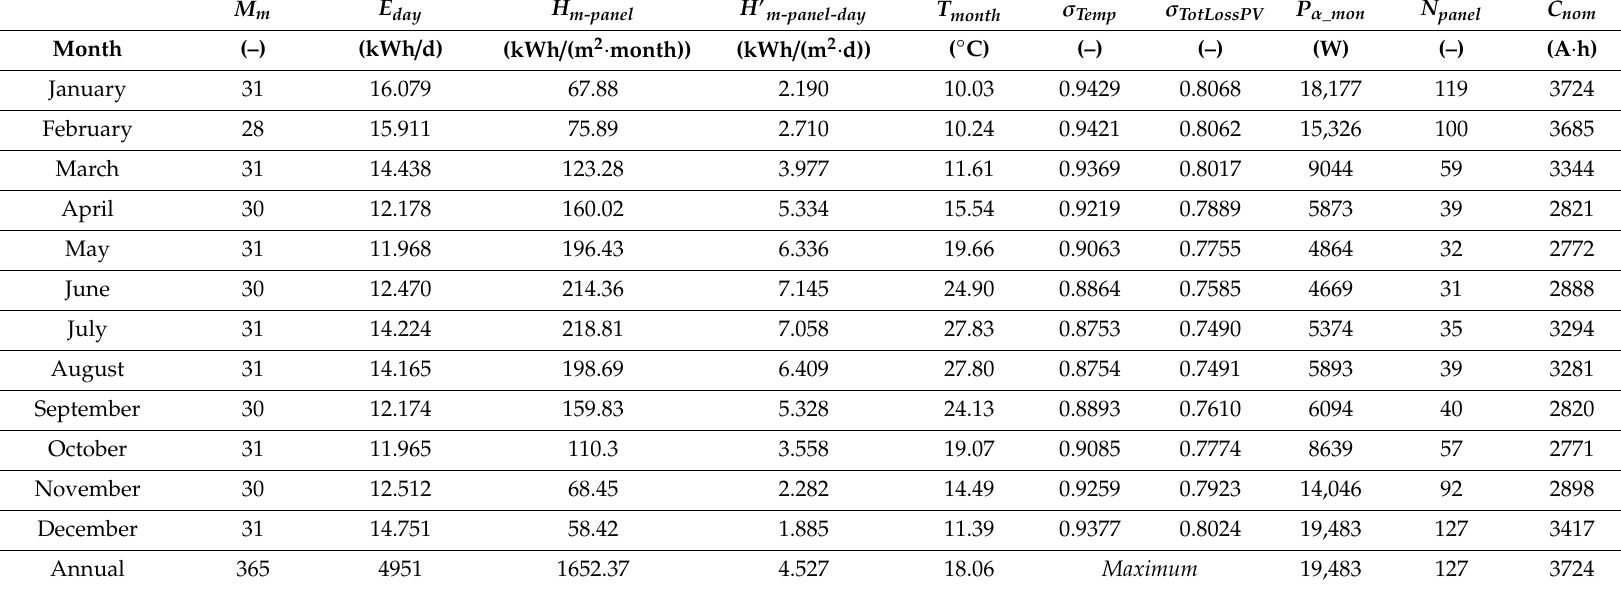
Table 4. Calculation of the essential photovoltaic panels (PVs) power supply of the population of PVs and of the battery capacity with respect to mean monthly solar radiation with an angle inclination of 3 ◦ and null shadow angle in Stachtoroi Island,